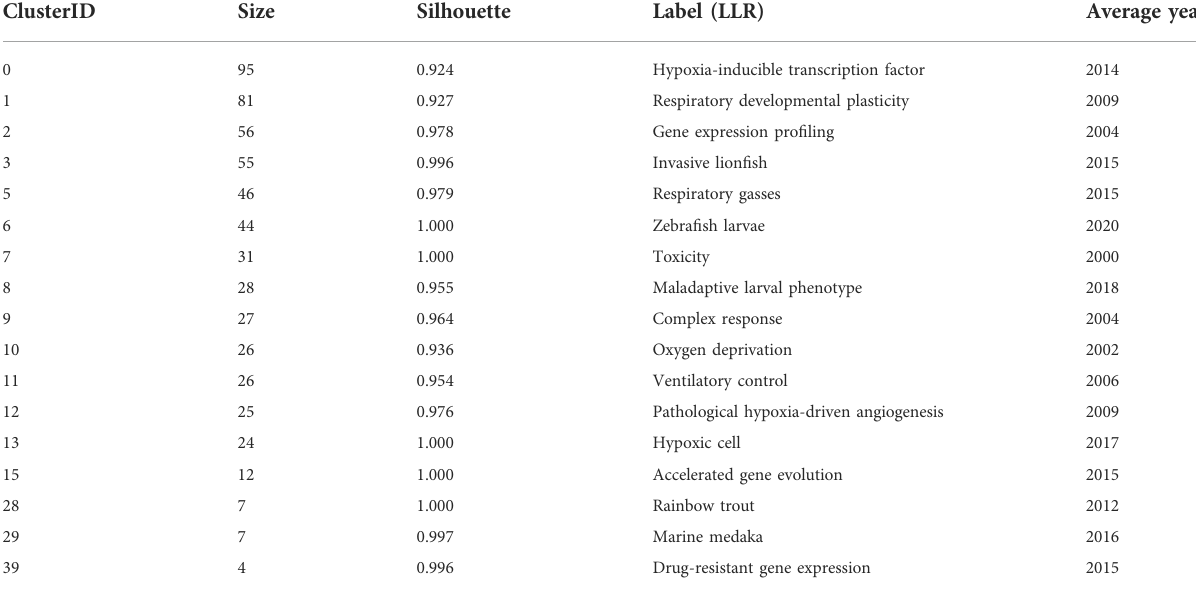
TABLE 9 Seventeen (17) major clusters from the article co-citation analysis for research on zebra fi sh and climate changes. ClusterID Size